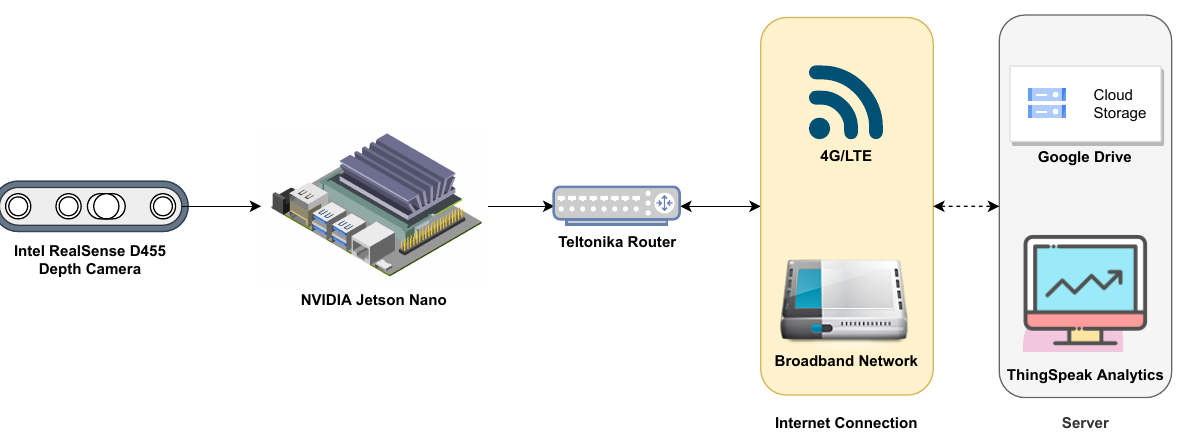
Figure 6. System setup of our proposed computer vision and edge-computing-based IoT real-time flood monitoring